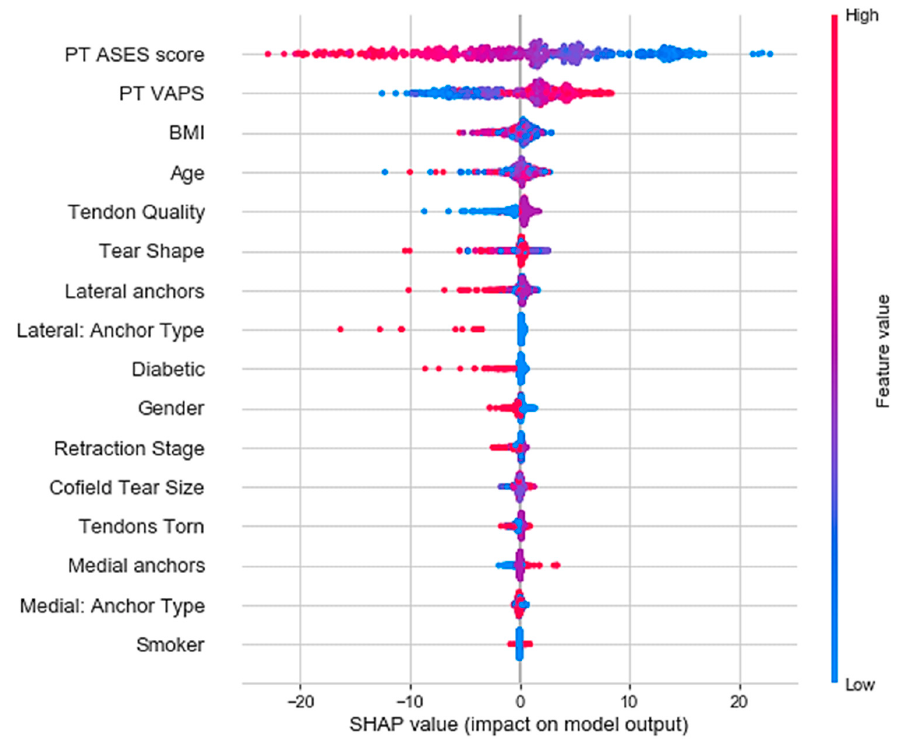
Figure 6. Relative importance of various features on the prediction of 12-month post-operative ASES score.